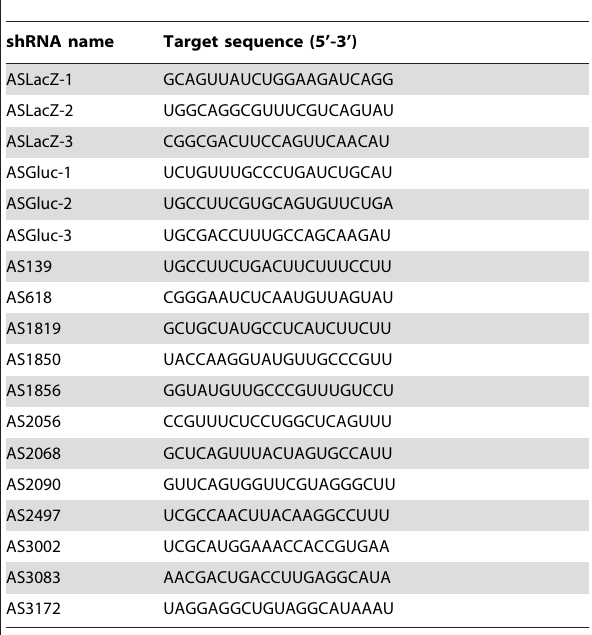
Table 1. Target sequences of the shRNAs.